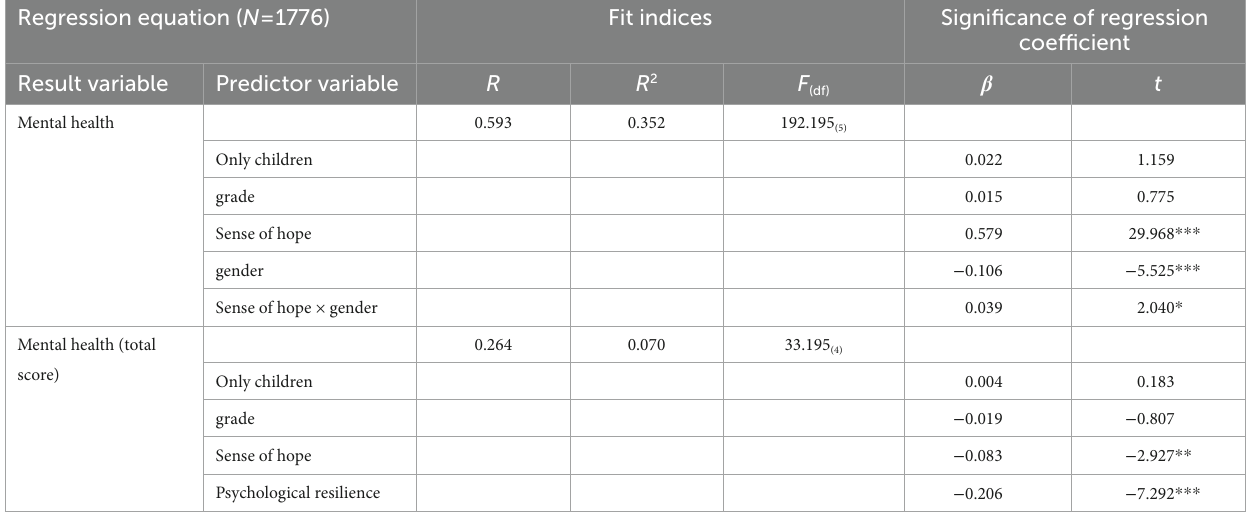
TABLE 4 The moderating effect of the gender on the mediating effect. Regression equation ( N =